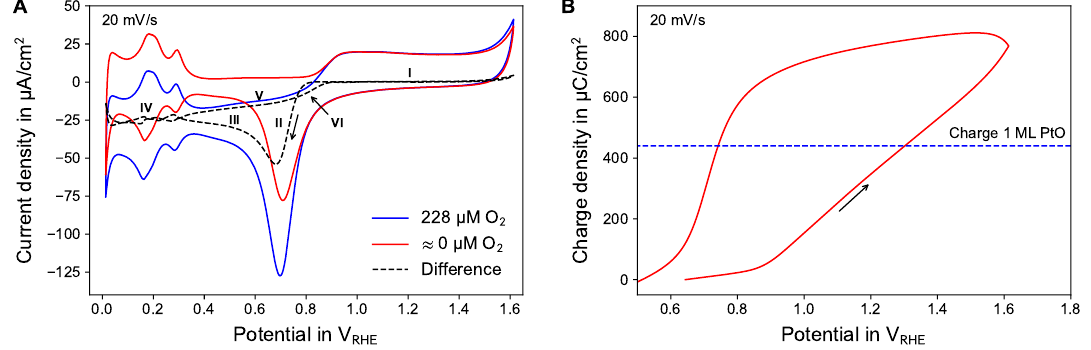
Figure 2. ( A ) Cyclic voltammograms (CV) of platinum in air-saturated (dashed curve) and nitrogen flushed (dotted curve) in 0.1 M PBS. The difference signal (solid curve) is assumed to represent mainly the oxygen reduction process at platinum. ( B ) Charge (integral of the current in A) for the nitrogen flushed CV in the region of platinum oxide formation. The dashed line represents the charge needed to form 1 monolayer (ML) of